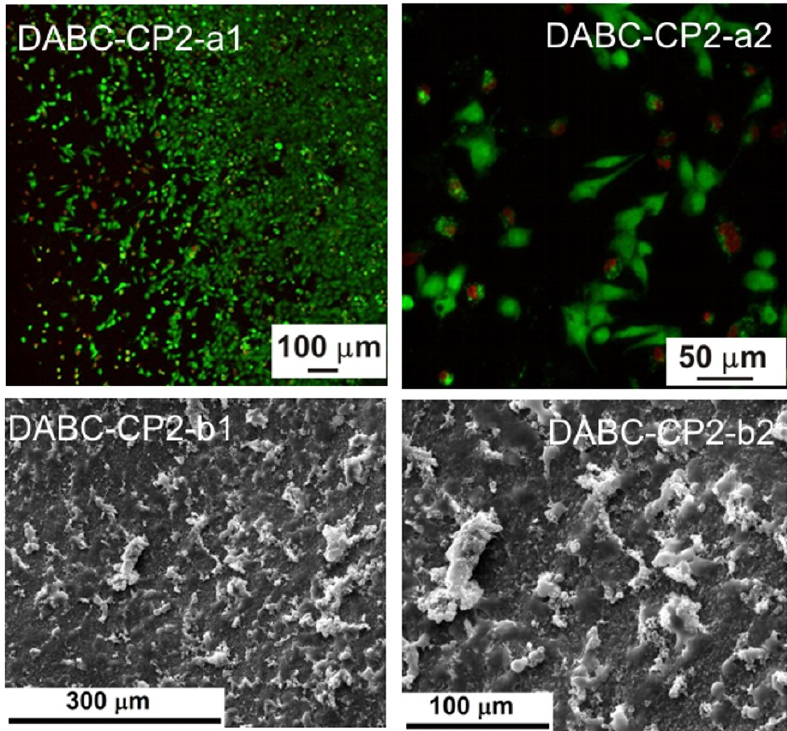
Figure 13. Fluorescence microscopy images ( a1 , a2 ) and SEM images ( b1 , b2 ) of the adherent cells in a DABC ‐ CP1 sample.